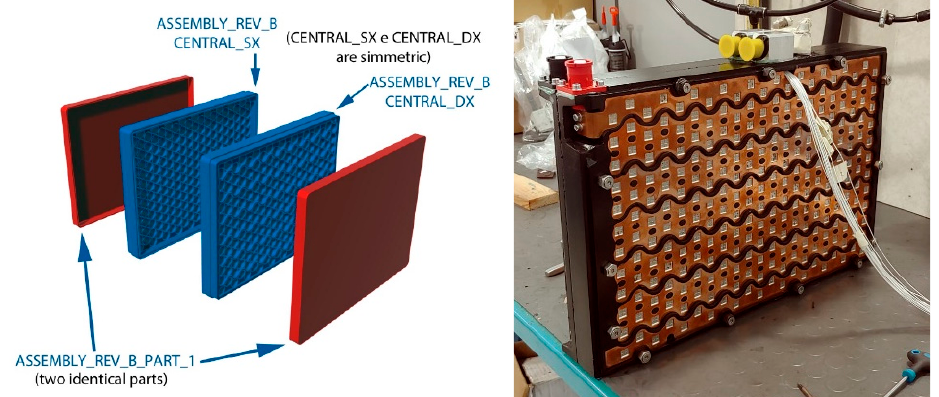
Figure 11. Battery module prototype.